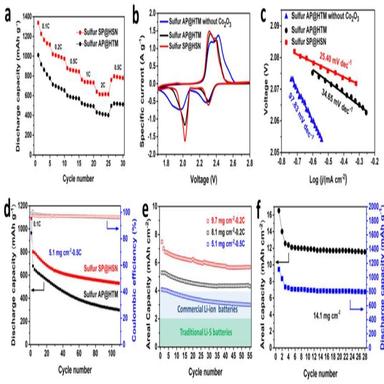
Electrochemical performance of SP@HSN based Li-S battery evaluated in coin cells. (a) Comparison of C-rate performance between sulfur SP@HSN and sulfur AP@HTM cathodes. (b) CV curves of SP@HSN particles with Co2O3 nanoparticles at a scanning of 0.1 mV s−1, as compared with AP@HTM with or without Co2O3. (c) Tafel slope comparison for the sulfur SP@HSN, AP@HTM with or without Co2O3. (d) Comparison of cycle performance of sulfur SP@HSN and sulfur AP@HTM cathodes with a sulfur loading of 5.1 mg cm−2 at 0.5 C. (